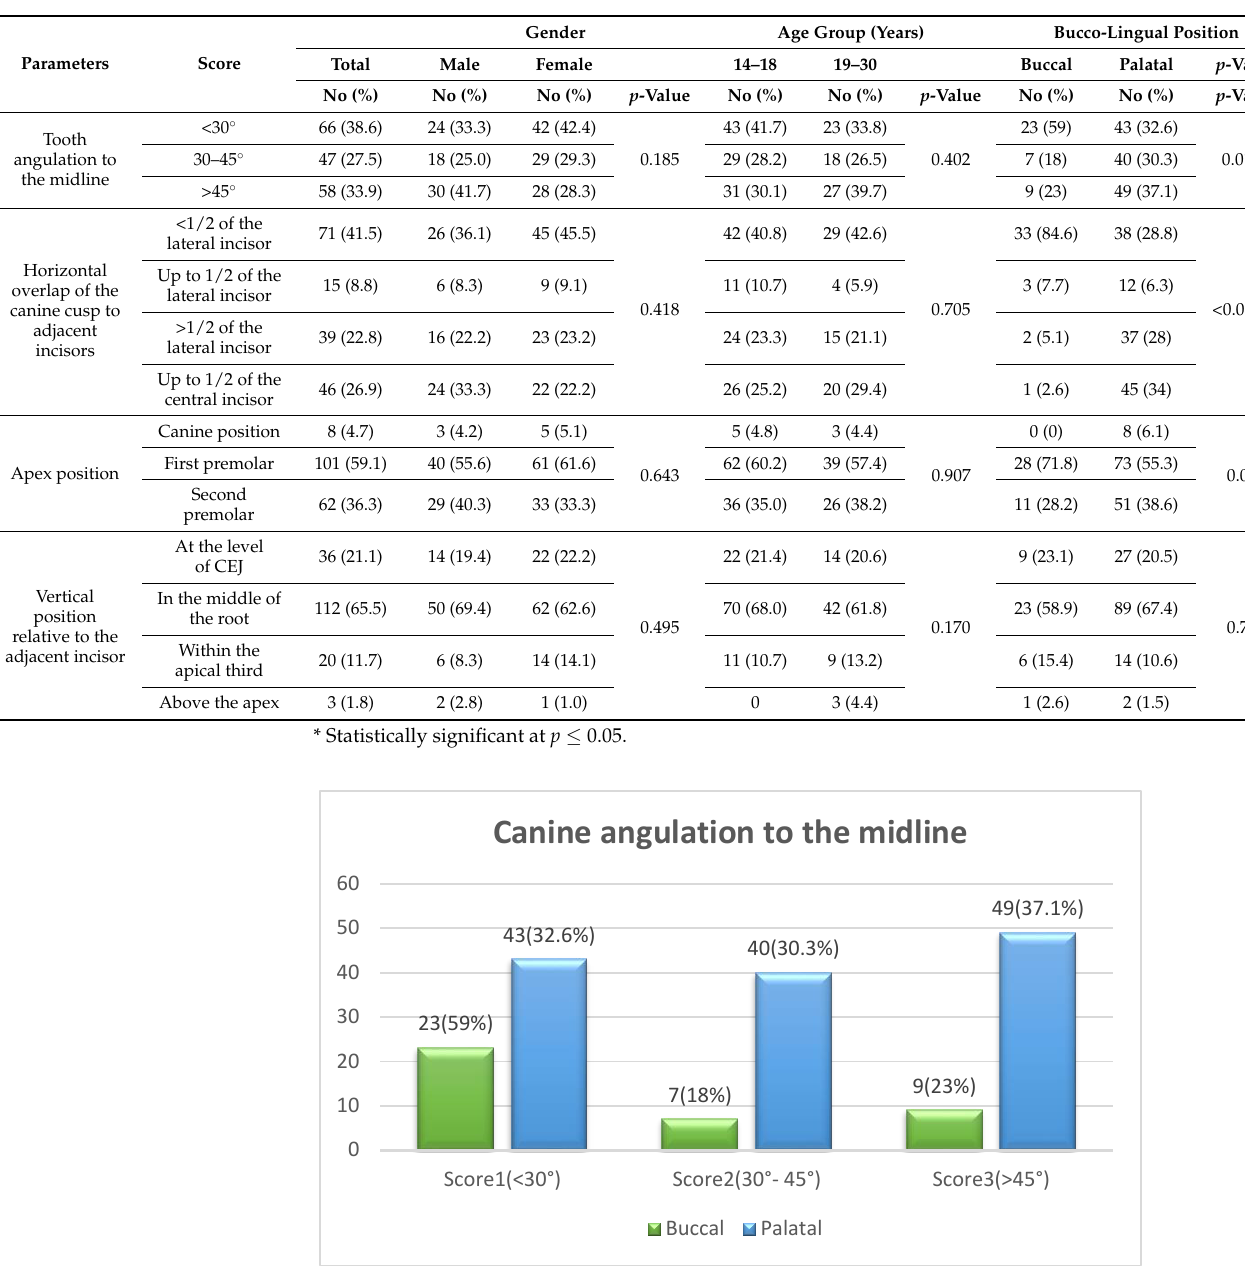
Figure 6. Comparison between buccal – palatal canine impaction and the horizontal overlap of the impacted canine crown tip with adjacent teeth using the chi-square test (X 2 = 40.7, df = 3, p < 0.001 *). * Statistically significant at p ≤ 0.05. 3.2. The Total Treatment Difficulty Index The descriptive values of the weighted scores of the treatment difficulty index, in addition to the differences across genders, are shown in Table 4. The mean score of the age of the subjects (4.68 ± 1.2), vertical position (2.91 ± 0.94), horizontal position (4.7 ± 0.85), and canine space available (2.73 ± 0.85) were all found to be significantly high overall. No